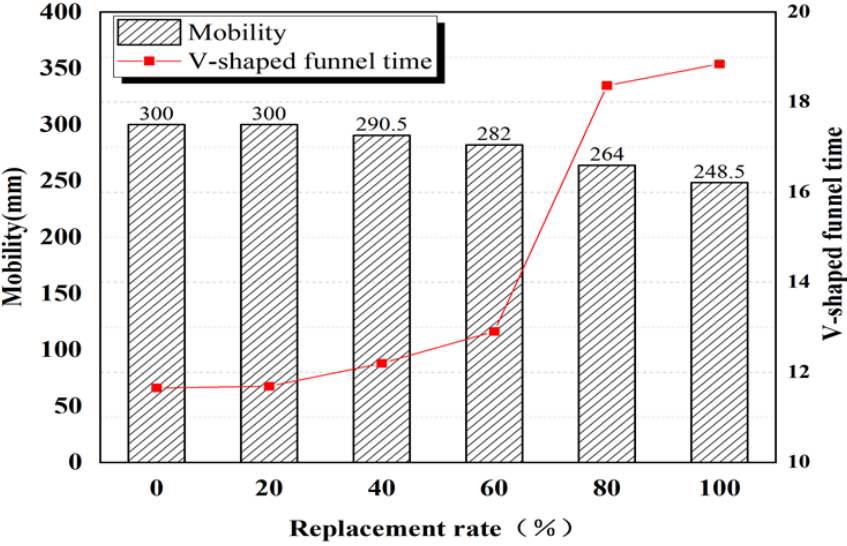
Figure 10. Flow performance of superfine Yellow River sand high-strength concrete.